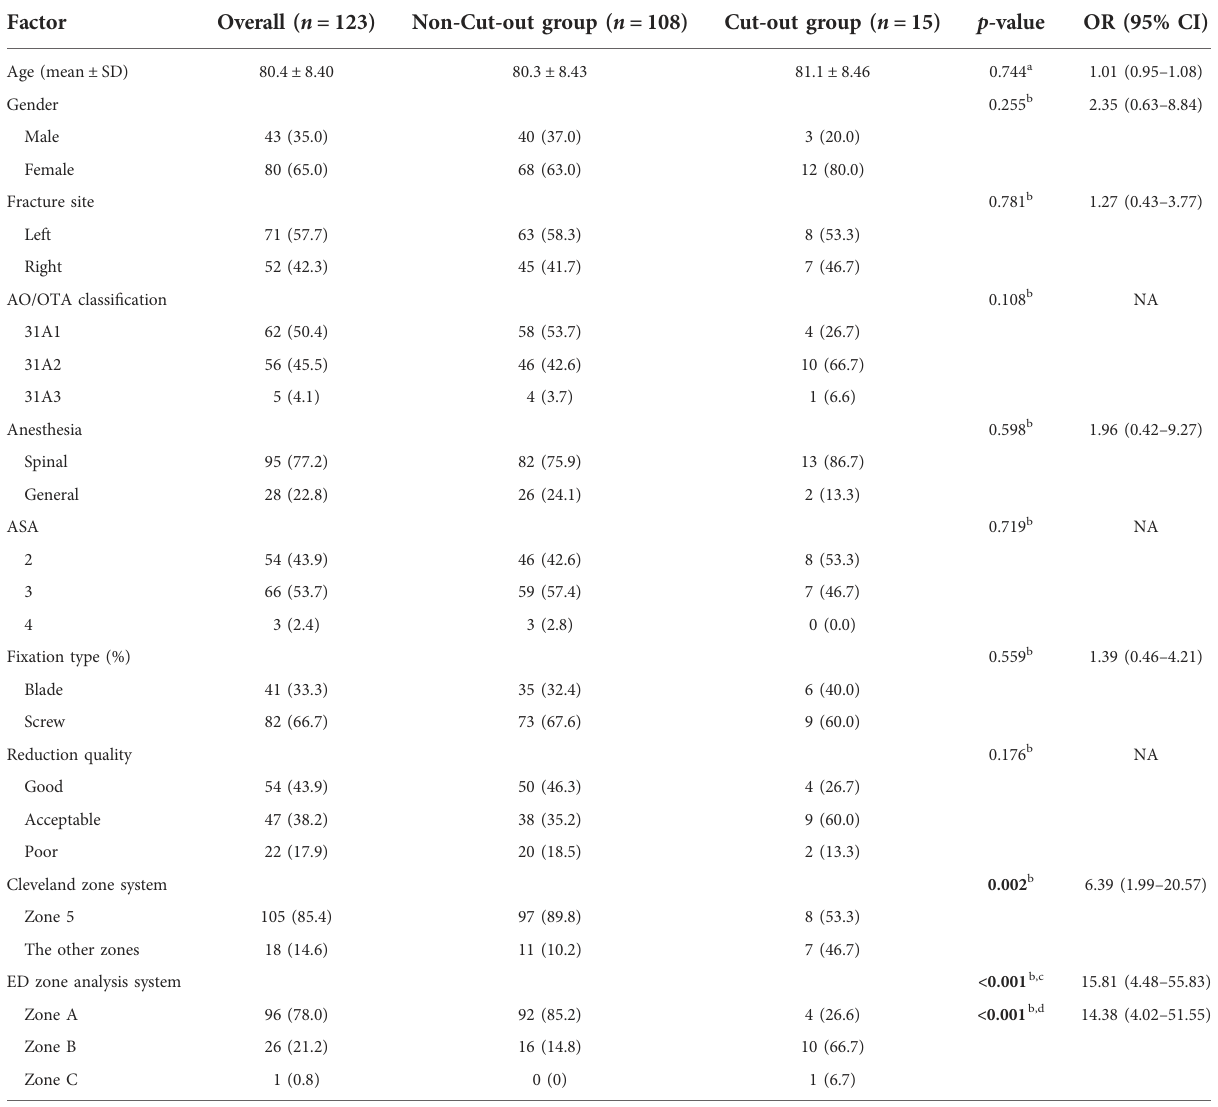
TABLE 1 Univariate analysis of collected